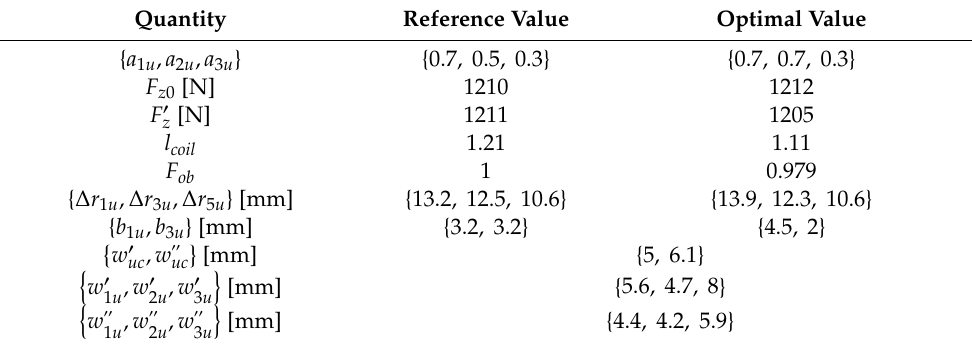
Table 3. Main data involved in the parametric analysis.